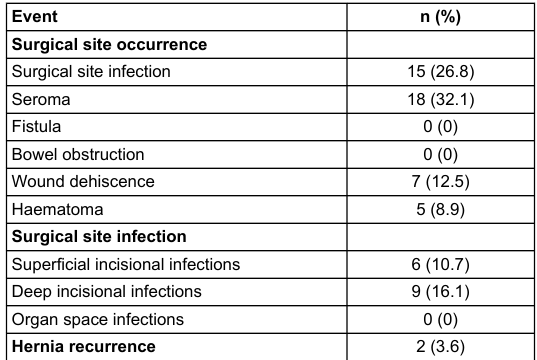
Table 4: Postoperative wound events (n = 56).